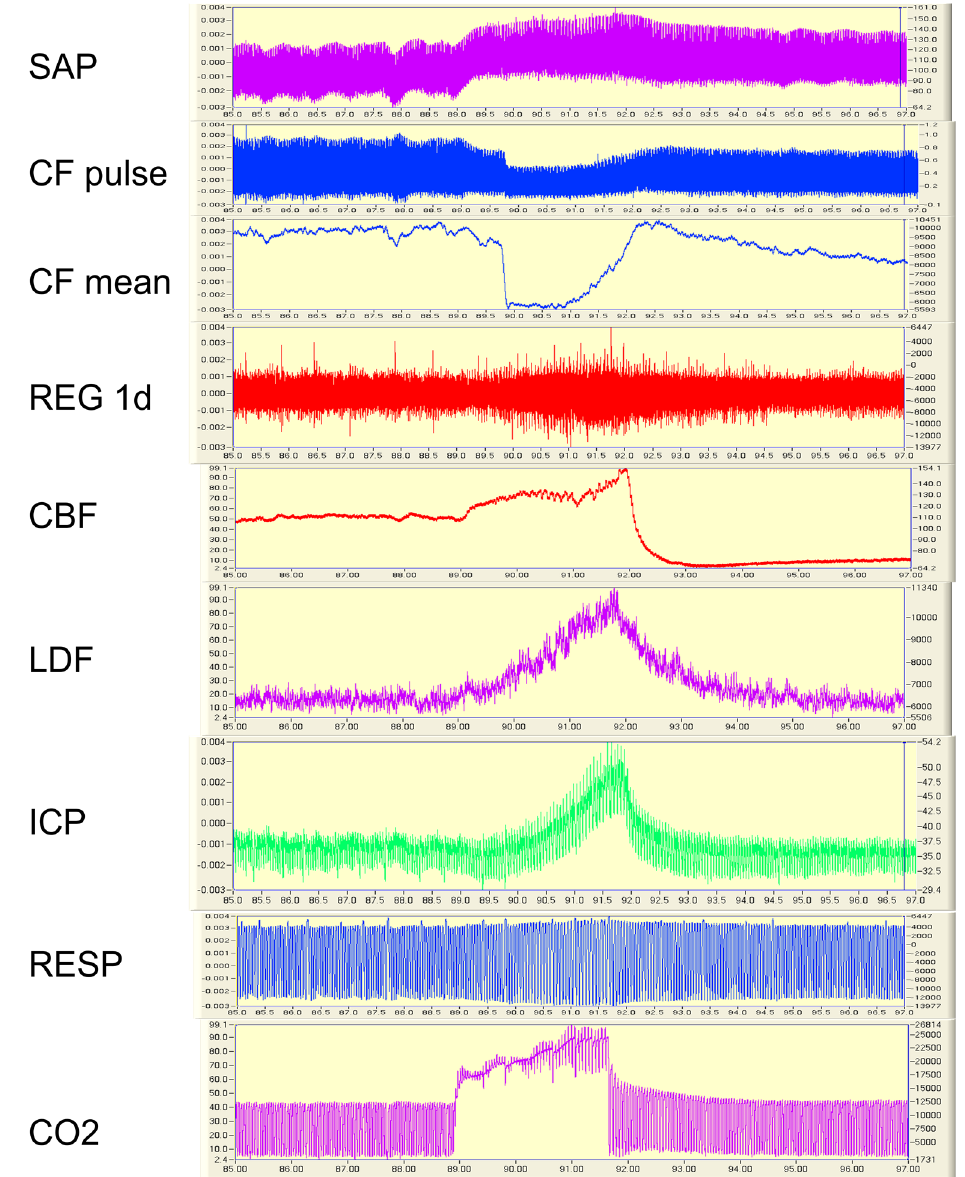
Fig. 2: Polygraphic traces during CO 2 inhalation. Abbreviations are as in Fig 1. RESP: respiration. As a function of CO 2 increase, ICP, CBF, LDF, REG 1st derivative and SAP increased; both CF pulse amplitude and mean value decreased. Pig recording of 5/22/07; time window 85-97 min.